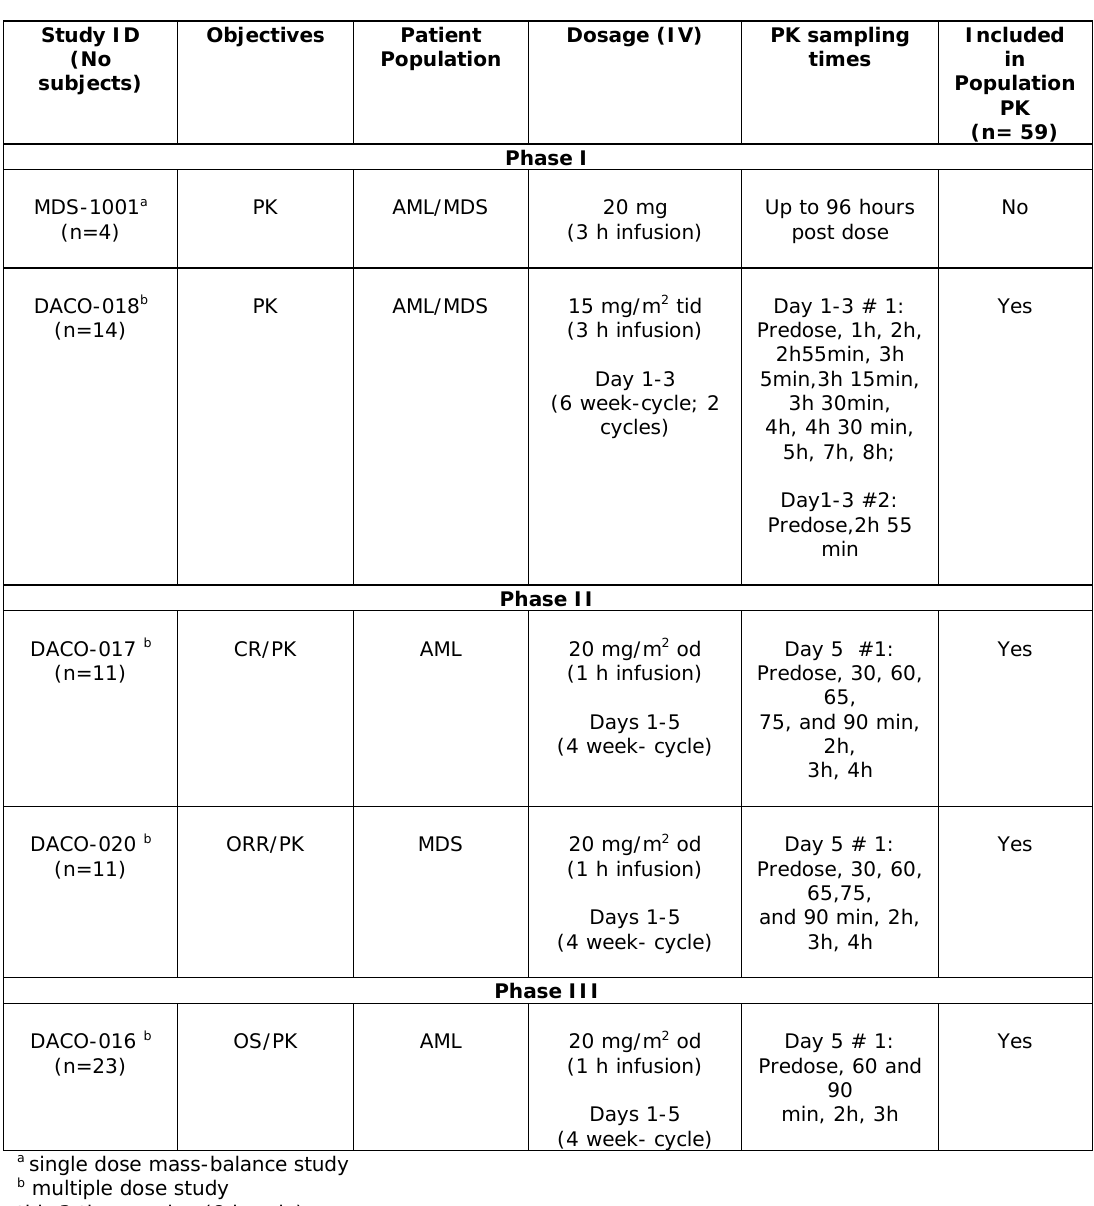
Table 14 :Clinical Pharmacology Studies included in the PK Analysis (n=